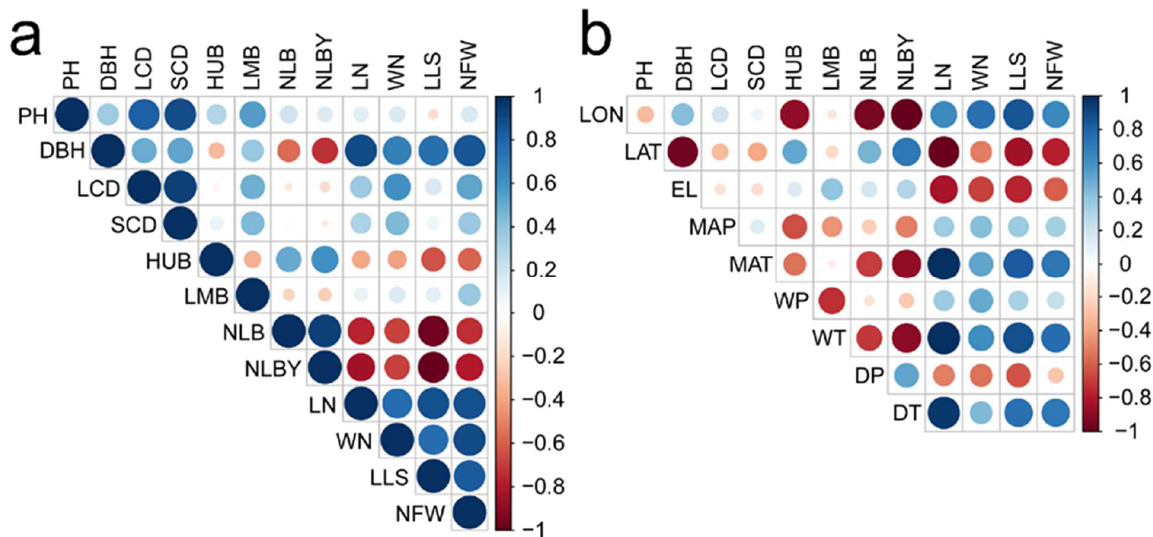
Figure 4. Correlation analysis among phenotypic traits ( a ) and spatial arrangement and ecological factors ( b ) of P. yunnanensis . Blue represents positive correlation while maroon represents negative correlation. The darker the color, the stronger the correlation. Phenotypic trait abbreviations are shown in Figure 2.